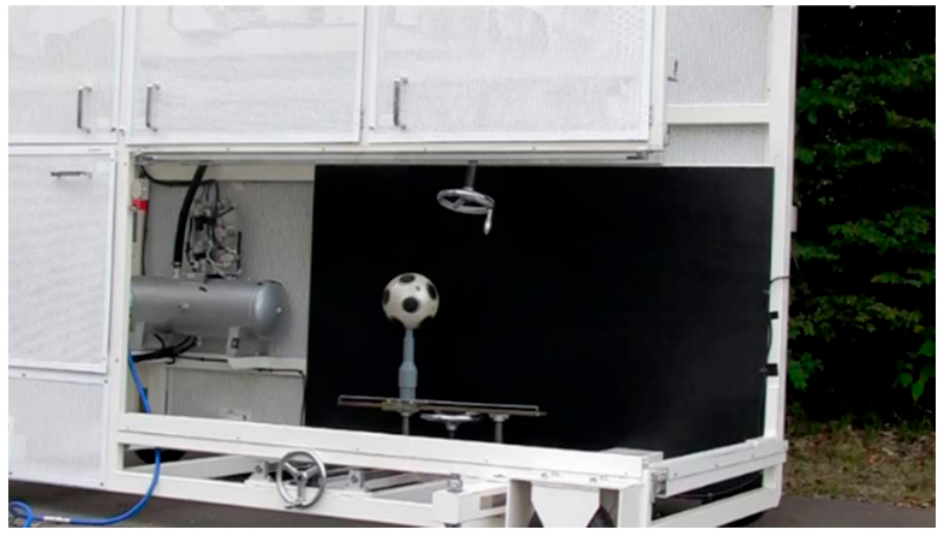
Figure 1. Kicking robot used to wear out soccer balls. The soccer balls used in this study were official balls used in the 2018–2019 season: 1 (cid:13) Telstar 18 (6-panel, Adidas) EPL (English Premier League) official soccer ball, 2 (cid:13) Merlin (4-panel, Nike) Seria A (Italian Football League) official soccer ball, 3 (cid:13) Derbystar (32-panel, Select Sports) Bundesliga (German Football League) official soccer ball. Three used and three new balls (Figure 2) were utilized in the wind tunnel